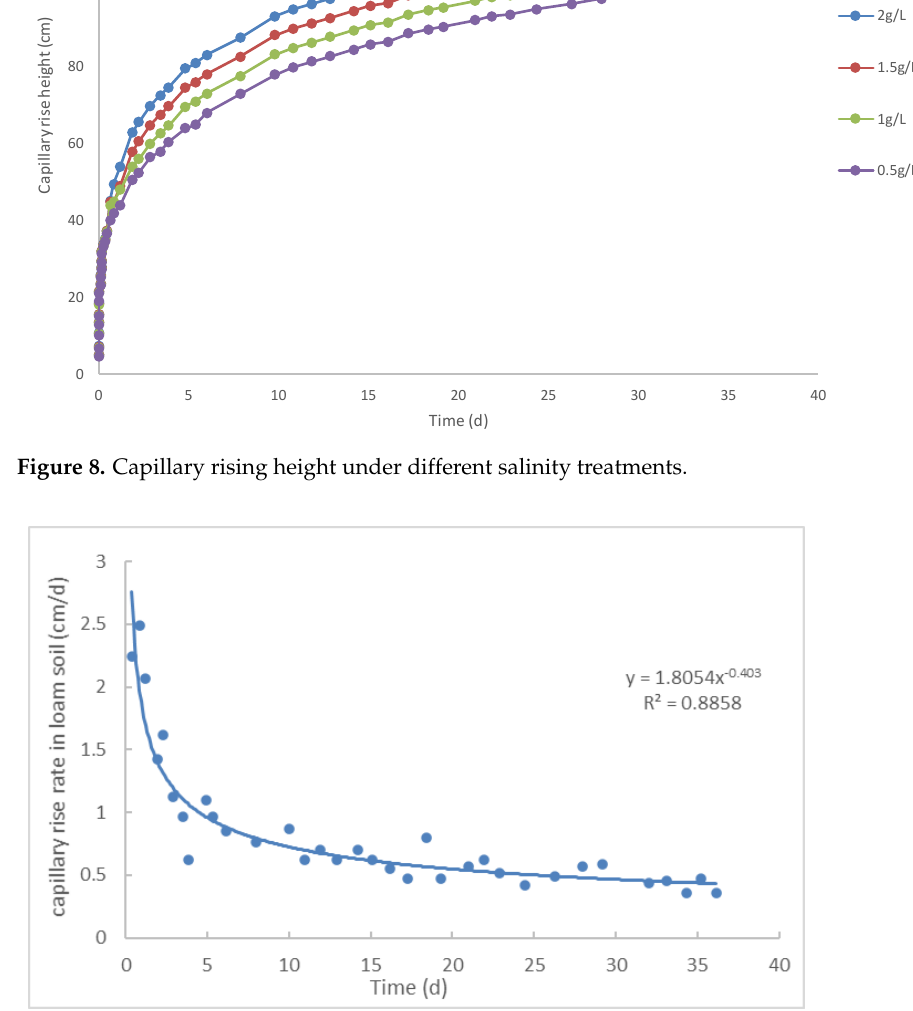
Figure 9. Variation curve of capillary rise rate in the loam soil. Table 2. The maximum capillary height under different treatment